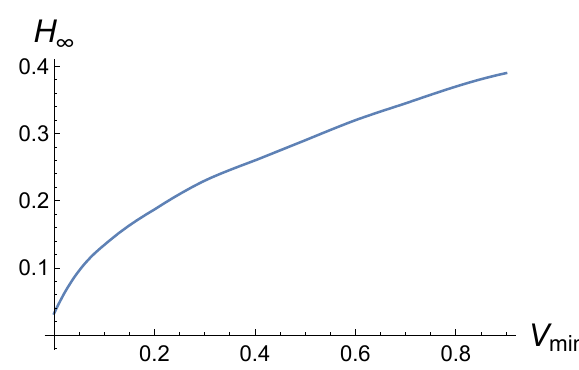
Figure 8 . The asymptotic value H ∞ as a function of the minimal value of the potential V min = C 1 − C 2 . The parameters are chosen as